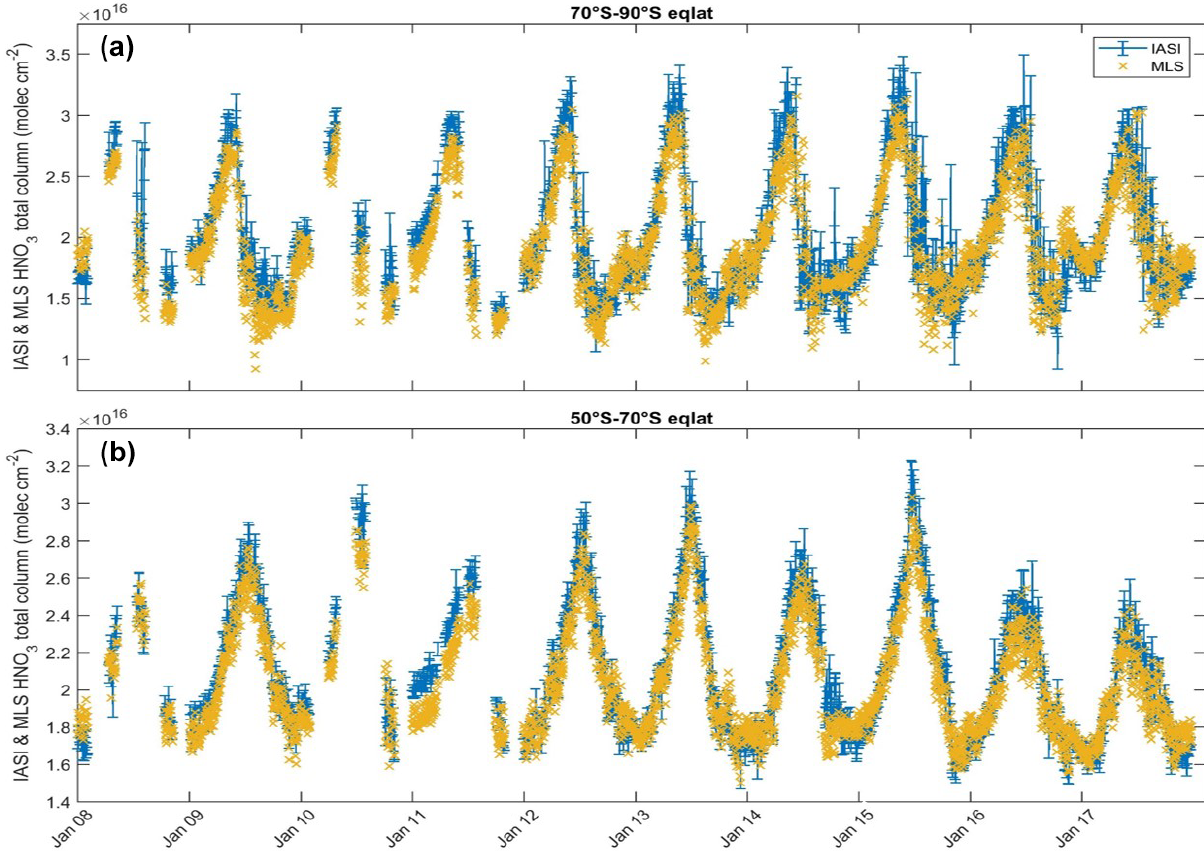
Figure 2. Time series of daily IASI total HNO 3 column (blue) co-located with MLS and of MLS total HNO 3 columns (orange) within 2.5 ◦ × 2.5 ◦ grid boxes, averaged in the 70–90 ◦ S (a) and the 50–70 ◦ S (b) equivalent latitude bands. Note that the MLS total column estimates were obtained by extending the MLS partial stratospheric column values using the FORLI-HNO 3 a priori information (see text for details). The error bars (blue) represent 3 σ , where σ is the standard deviation around the IASI HNO 3 daily